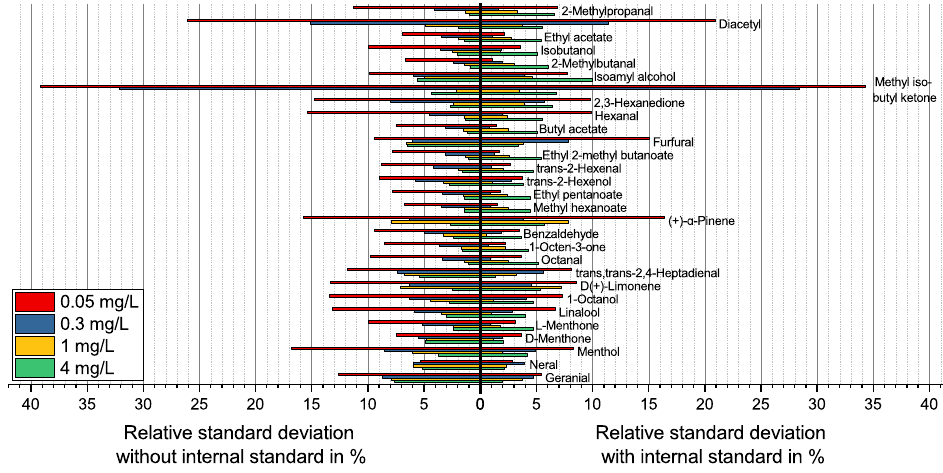
Figure A2. Diagram comparing the coefficient of variance or relative standard deviation of the signal intensity for all analyzed standard substances in a flavorless e-liquid at four different concentration levels and eleven measurements each, with or without the use of an internal standard to reduce matrix effects.